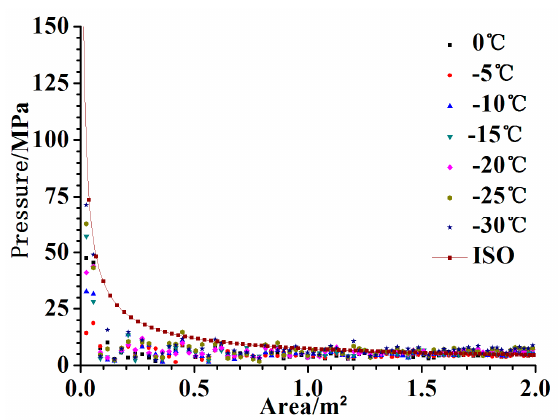
Figure 12. Failure strain - temperature curve.